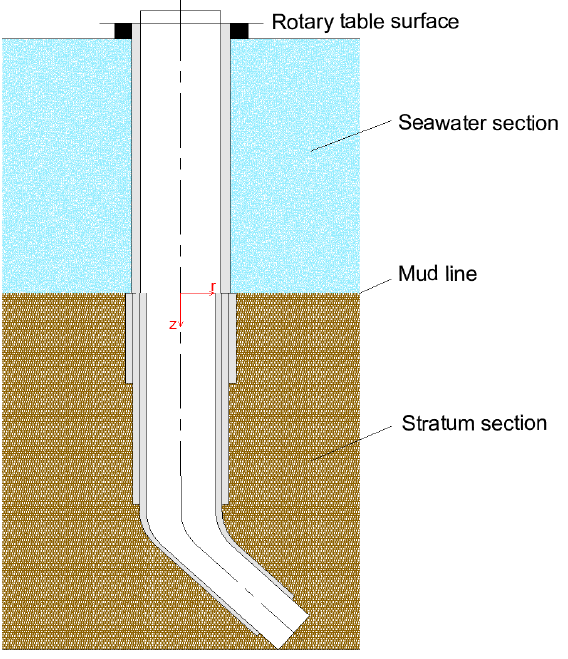
Figure 1. Schematic diagram of the body structure of HTHP directional well.